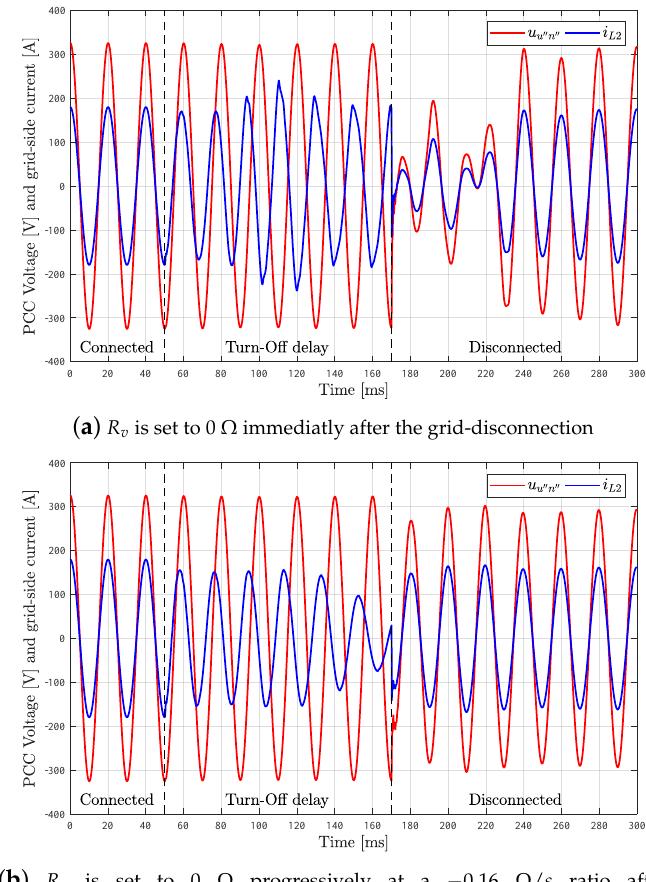
Figure 9. R v (0.2 Ω initially) effect during grid-connected to grid-disconnected transference at t = 50